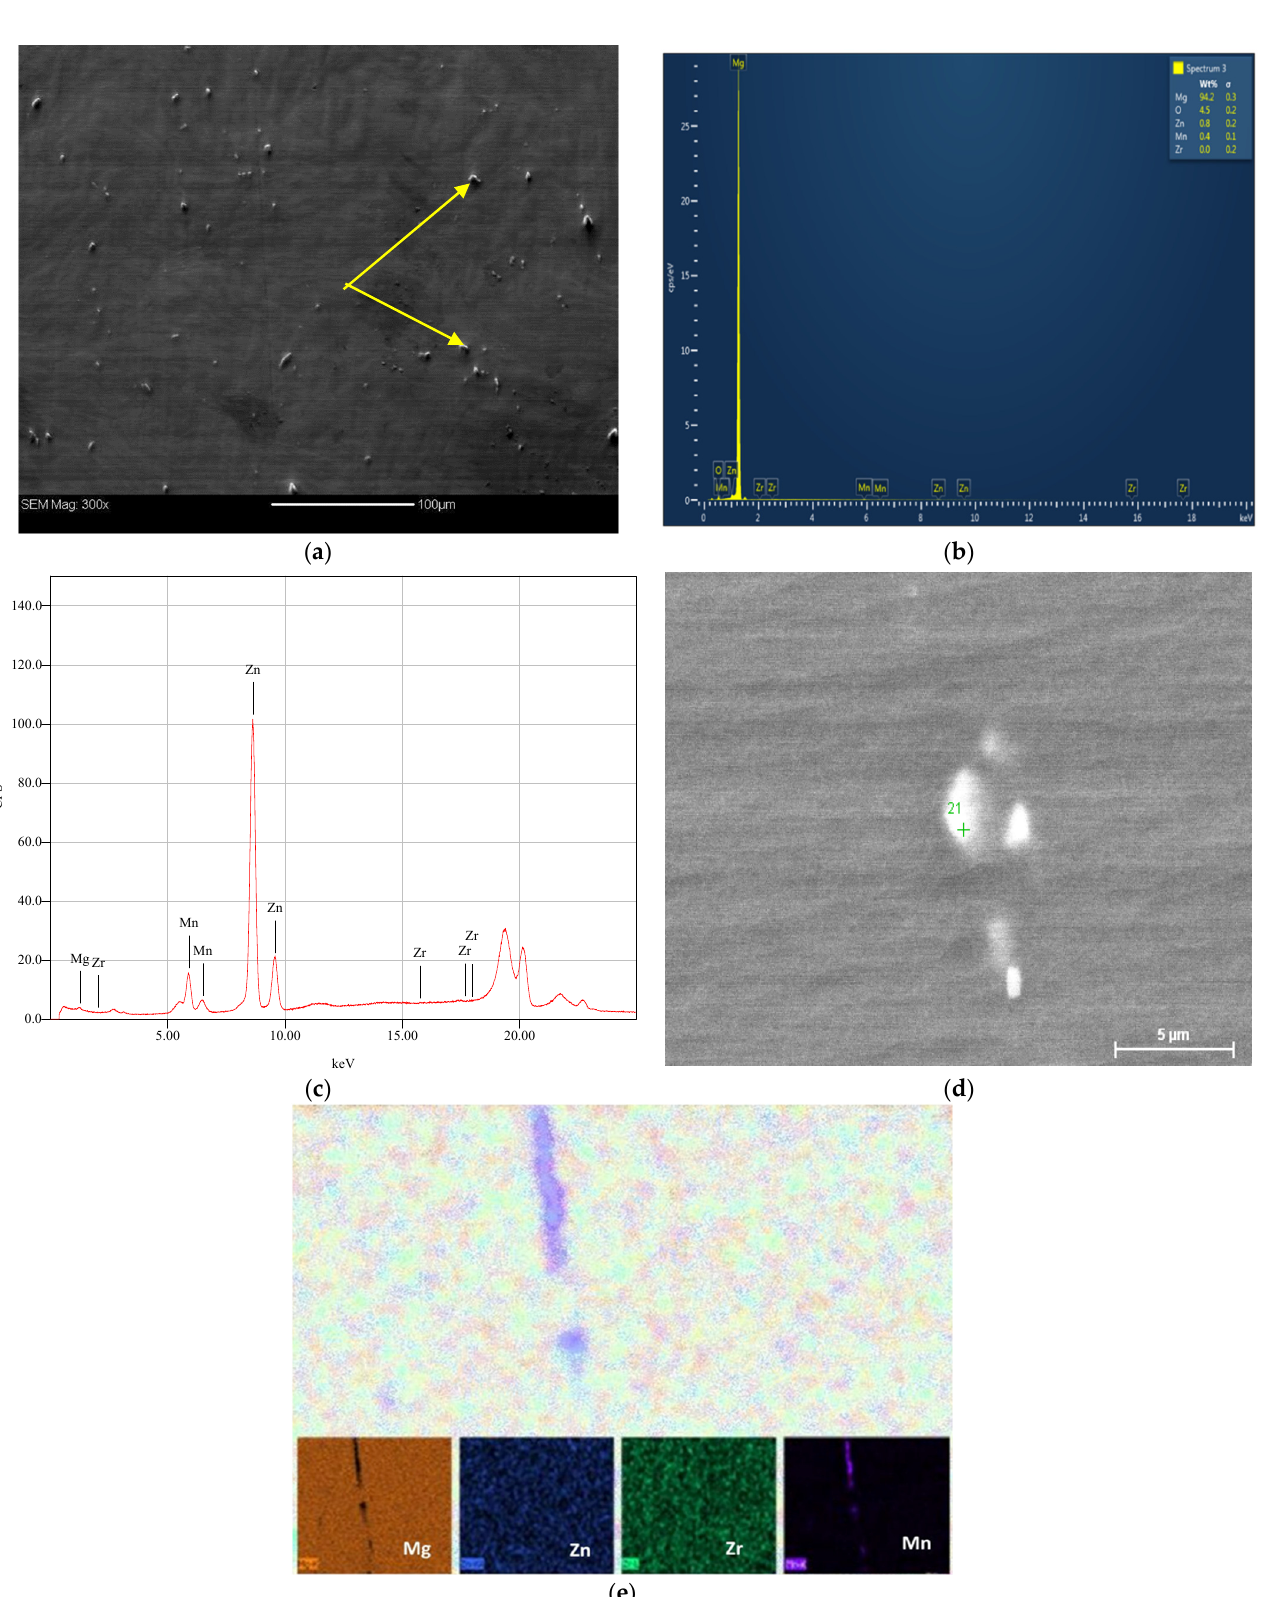
Figure 2. ( a ) SEM micrographs, ( b ) EDS analysis, ( c ) XRF analysis, ( d ) SEM for the EDS area, and ( e ) elemental mapping of the AA ZK30 alloy; arrows point at second phases.